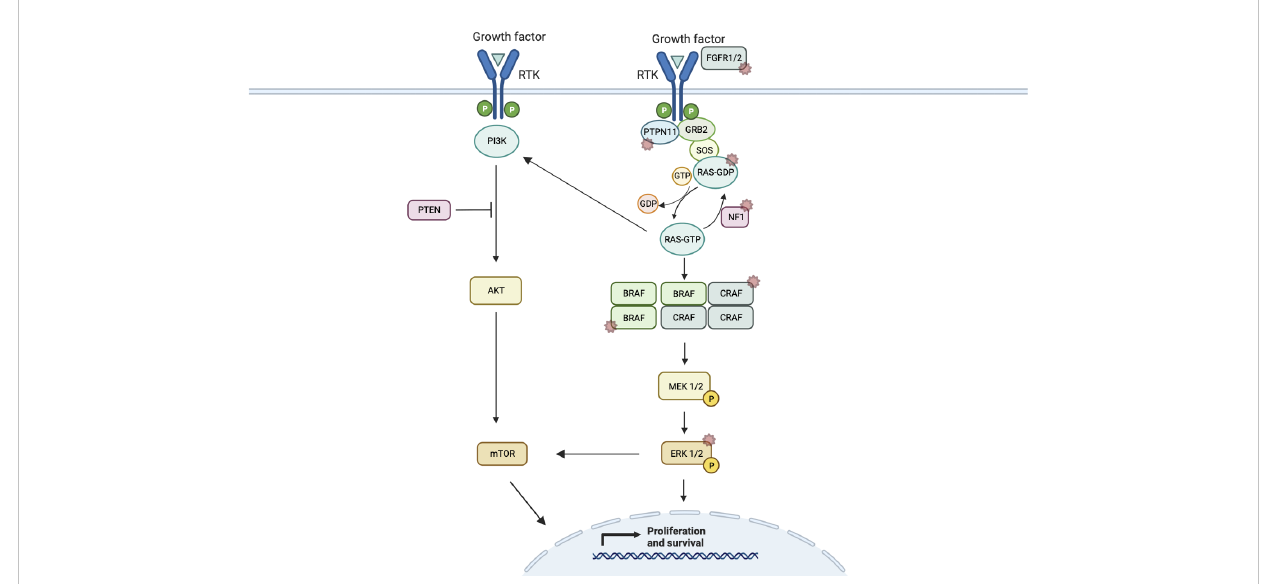
FIGURE 1 Schematic representation of ERK/MAPK pathway signaling showing normal dimerization of MAP3Ks and cross-signaling of the PI3K/AKT/mTOR pathway. Starred pathways indicate known alterations implicated in